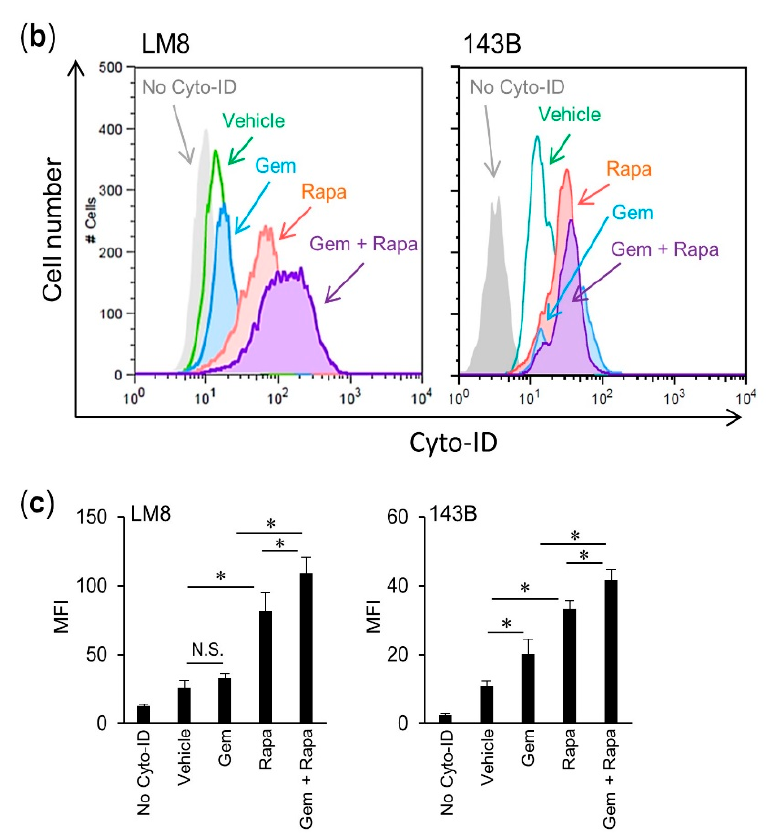
Figure 3. Rapa induced autophagy in OS cells. ( a ) LM8 and 143B cells were treated with Gem or Rapa and the levels of p62, microtubule-associated protein light chain 3 (LC3)-I/II, rapamycin-insensitive companion of mammalian target of rapamycin (RICTOR), and p70-S6 and their phosphorylated forms (as appropriate) were assessed by western blotting. See Supplementary Figures S5–S8 for examples of uncropped images and quantification the bands for each protein. ( b , c ) LM8 and 143B cells were loaded with Cyto-ID and treated with Gem alone or in combination with Rapa and analyzed by flow cytometry. Data are shown as the mean ± SD ( n = 3). * p < 0.05. MFI, median fluorescence intensity. N.S., not significant.